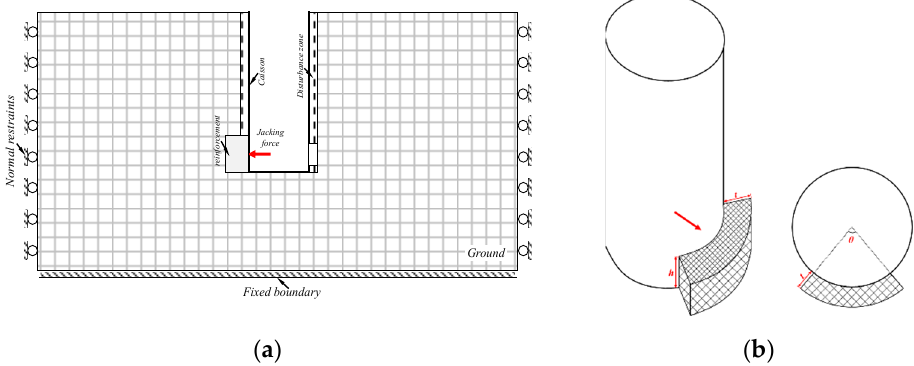
Figure 5. Schematic diagram of the numerical model: ( a ) Model profile view; ( b ) Schematic diagram of soil reinforcement.